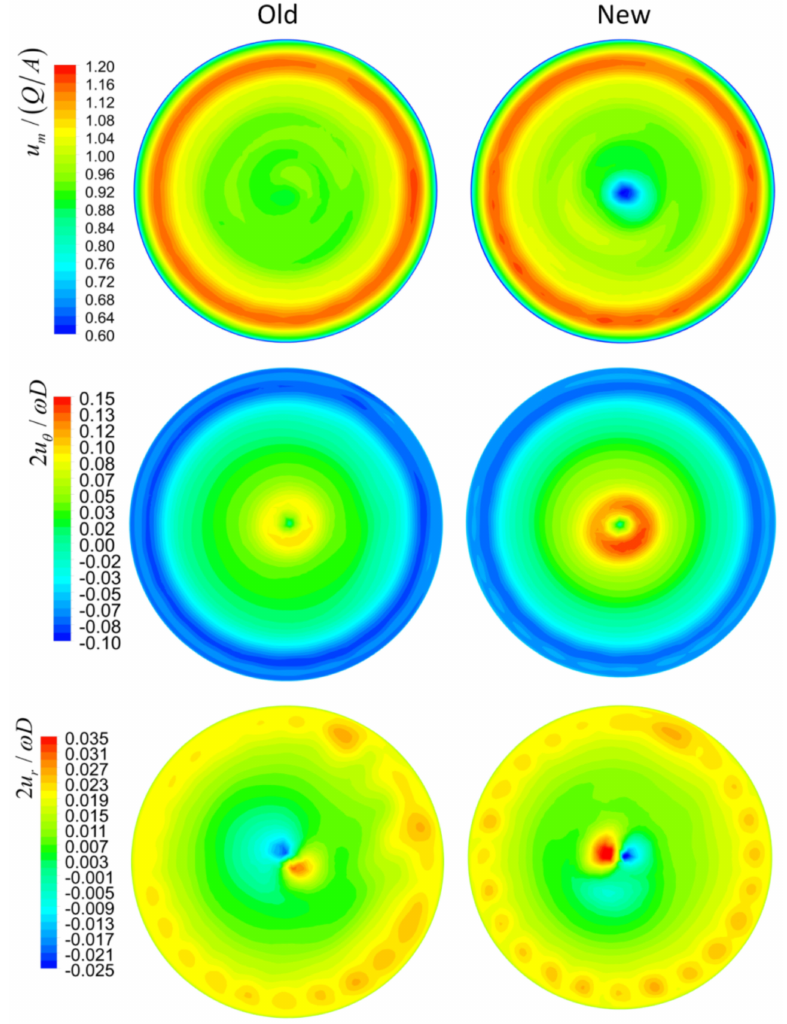
Figure 23. Axial, circumferential and radial flows at runner outlet of case 1 hydraulic turbine. Axial velocity is function of the inlet area of the draft tube and the turbine